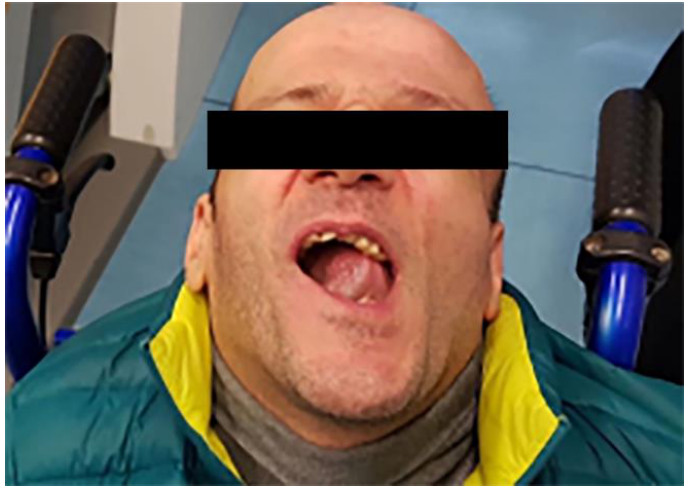
Figure 16. Case 5—Extraoral view of a patient with cerebral palsy.